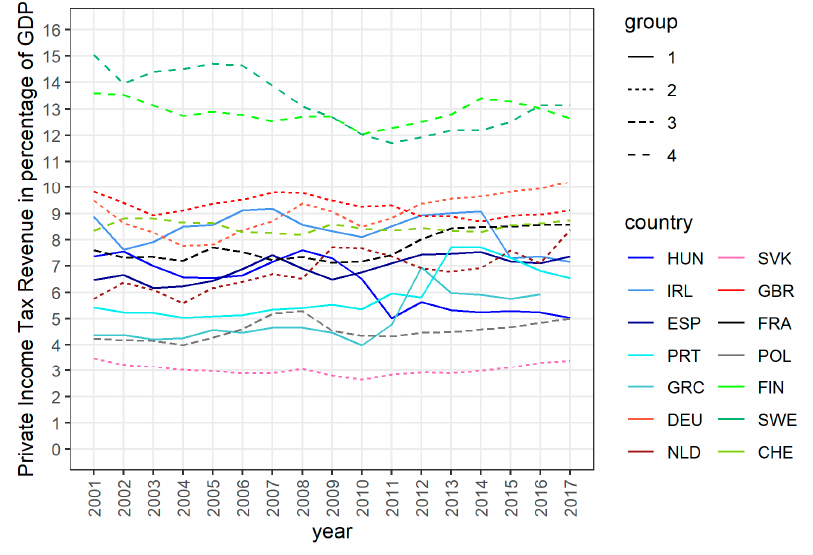
Figure 6. The development of private income tax revenues in analyzed countries.